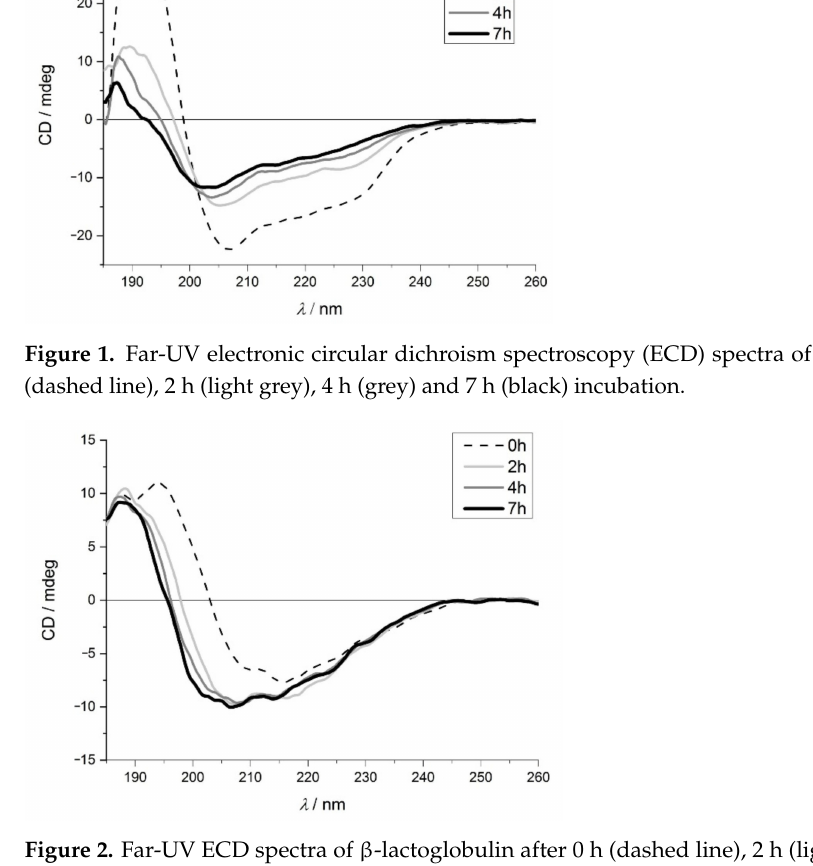
Figure 2. Far-UV ECD spectra of β -lactoglobulin after 0 h (dashed line), 2 h (light grey), 4 h (grey) and 7 h (black) of